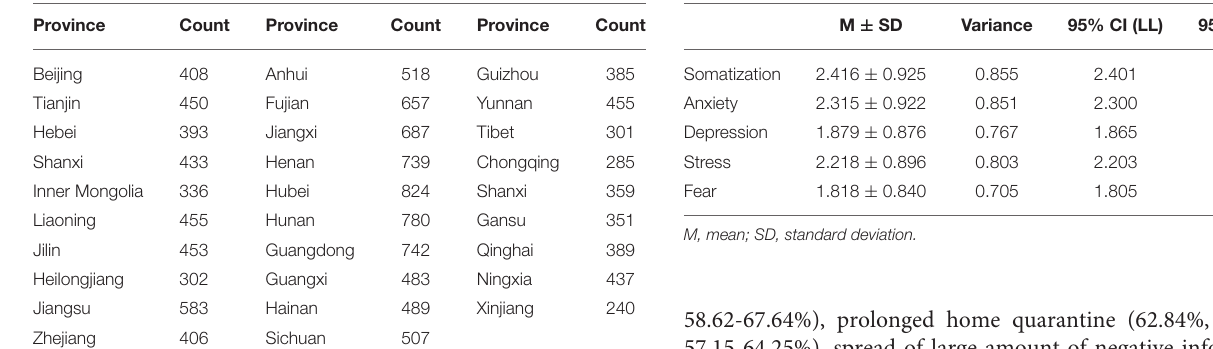
TABLE 2 | Distribution of respondents across provinces and cities. TABLE 3 | Mental health status during the COVID-19